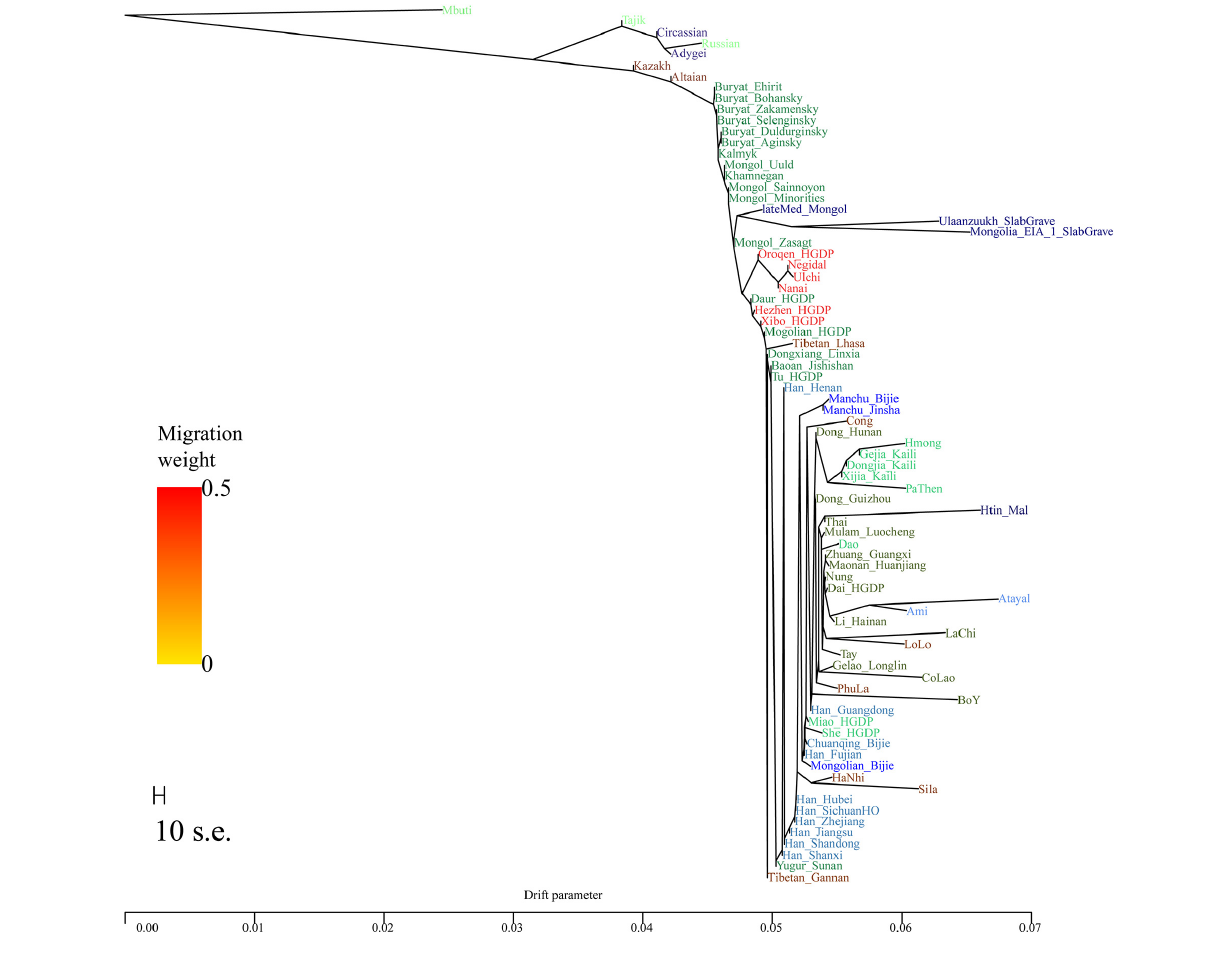
Frontiers in Genetics |